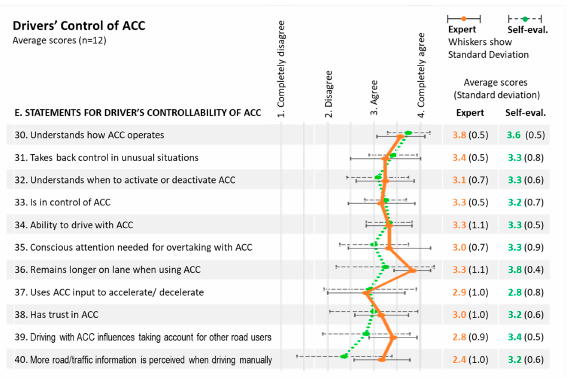
Figure 4. Comparison between self − evaluation and expert − assessment for control of